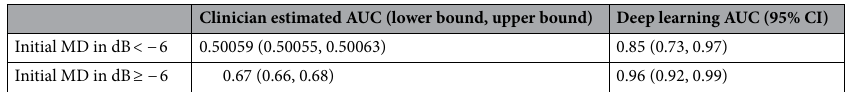
Table 3. Performance of deep learning model and clinicians at identifying VF worsening in a specific subpopulation of